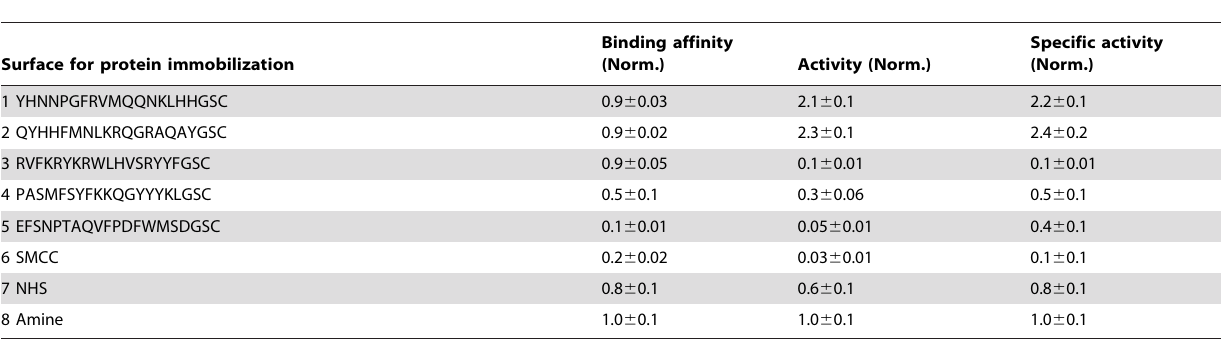
Table 1. Normalized activity and affinity of b -Gal immobilized on surface-modified microwells a .